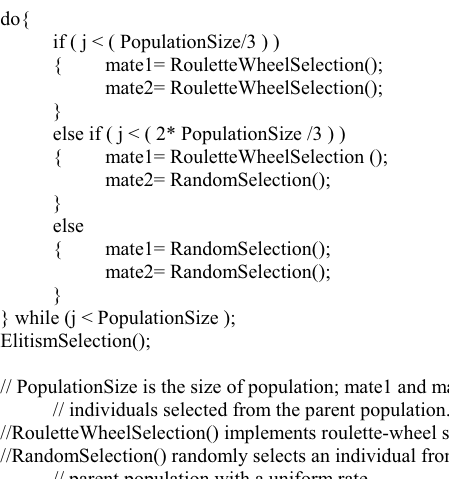
Fig. 2. The pseudo codes of the selection